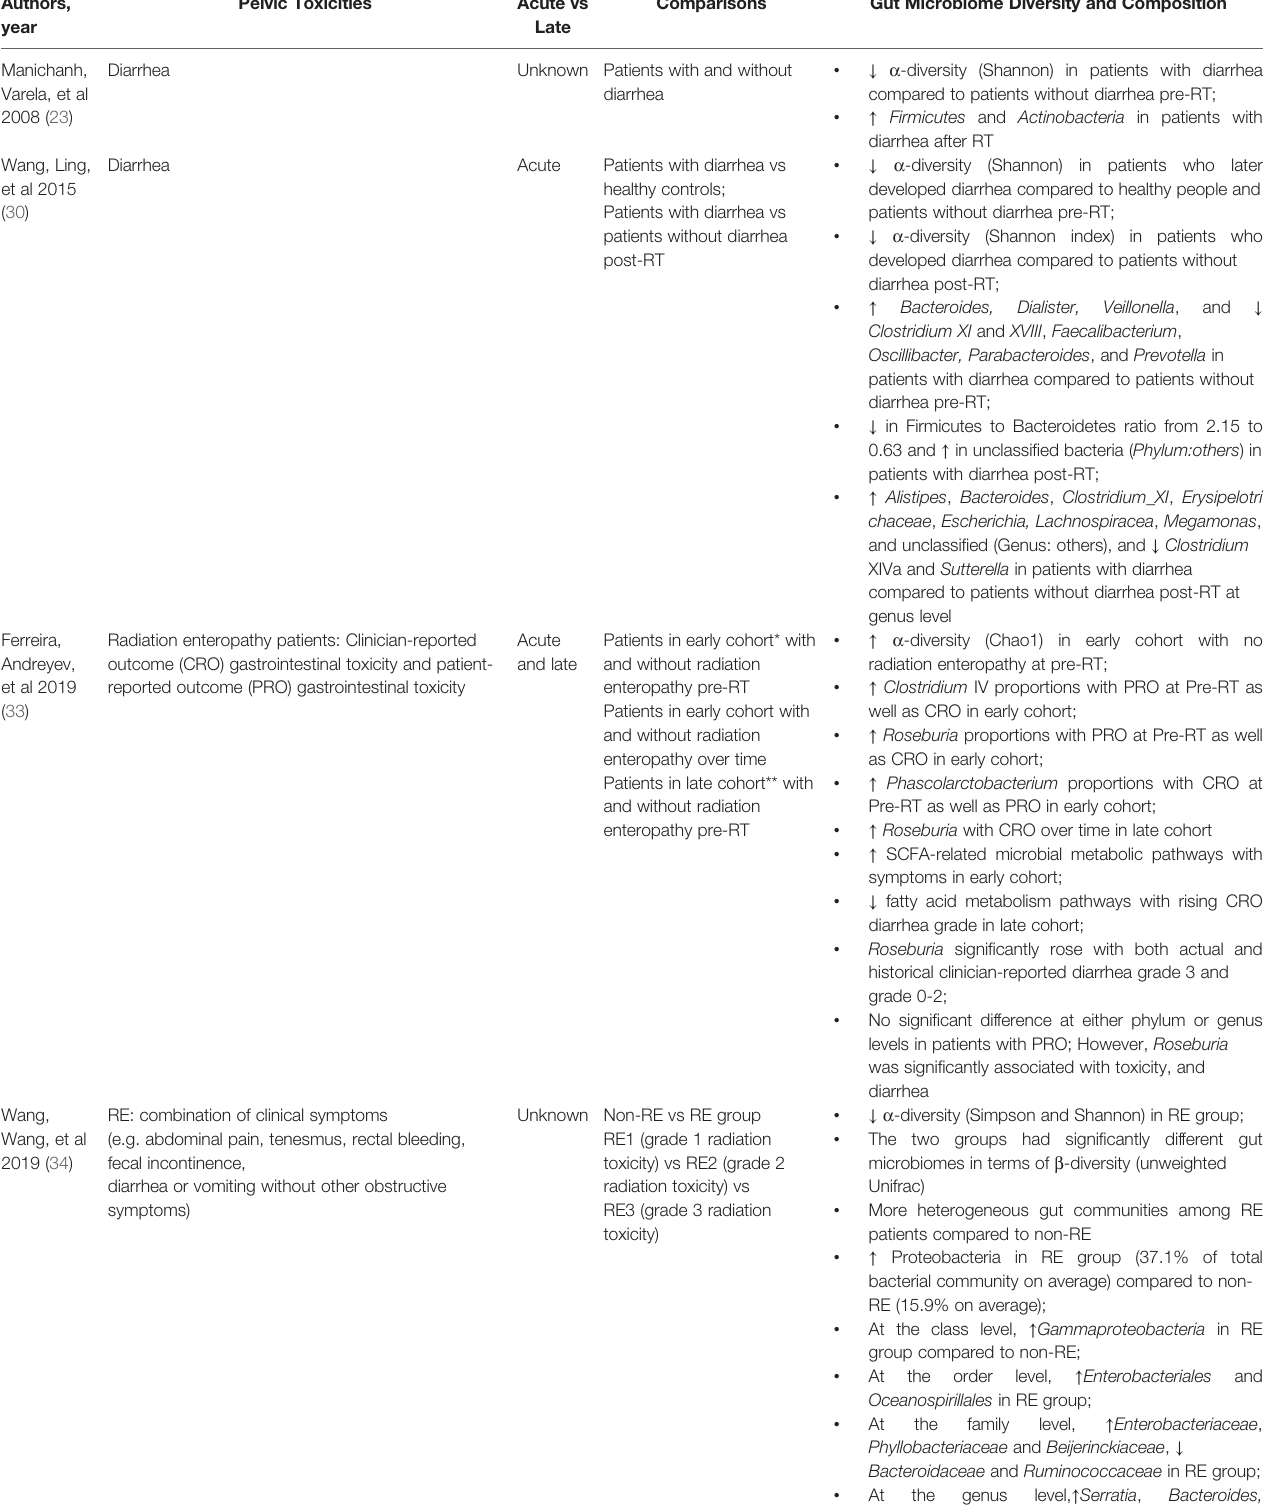
TABLE 3 | Associations of Radiation Therapy and the Gut Microbiome with Pelvic Toxicities. Authors,